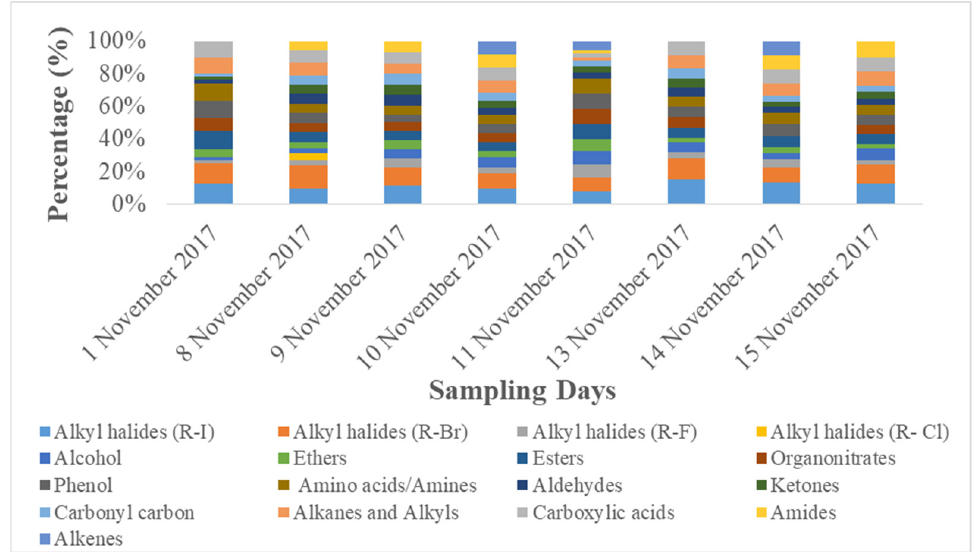
Figure 4. Percentage (%) contribution of different organic functional groups in PM 2.5